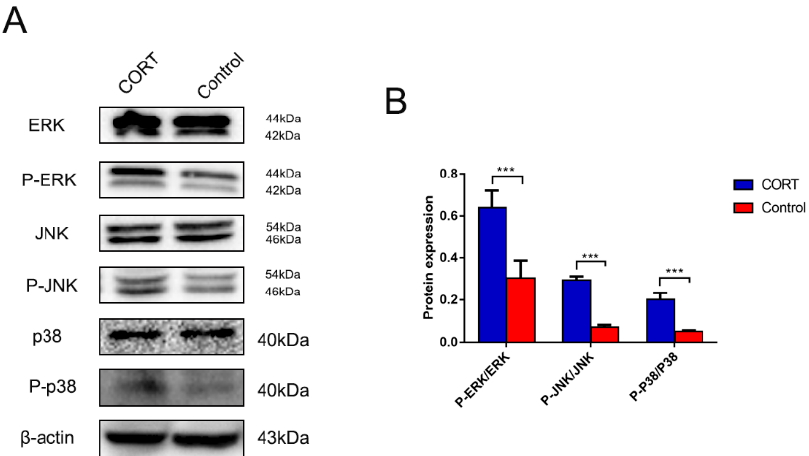
Figure 11. Expression of mitogen-activated protein kinase (MAPK) signaling pathway components in BV2 cells after cortisol (CORT) treatment (200 µ M) for 3 h, as assessed by western blotting. ( A ) Extracellular signal-regulated kinase (ERK), phospho- (p-)ERK (Thr202 / Tyr204), c-Jun N-terminal kinase (JNK), p-JNK (Thr183 / Tyr185), p38, p-p38 (Thr180 / Tyr182), and β -actin expression. Differences between control and CORT groups were evaluated by one-way analysis of variance. ( B ) Quantification of expression levels based on p-ERK / ERK, p-JNK / JNK, and p-p38 / p38 ratios. Results are expressed as the mean ± SD ( n = 3) of three independent experiments. *** p < 0.001.